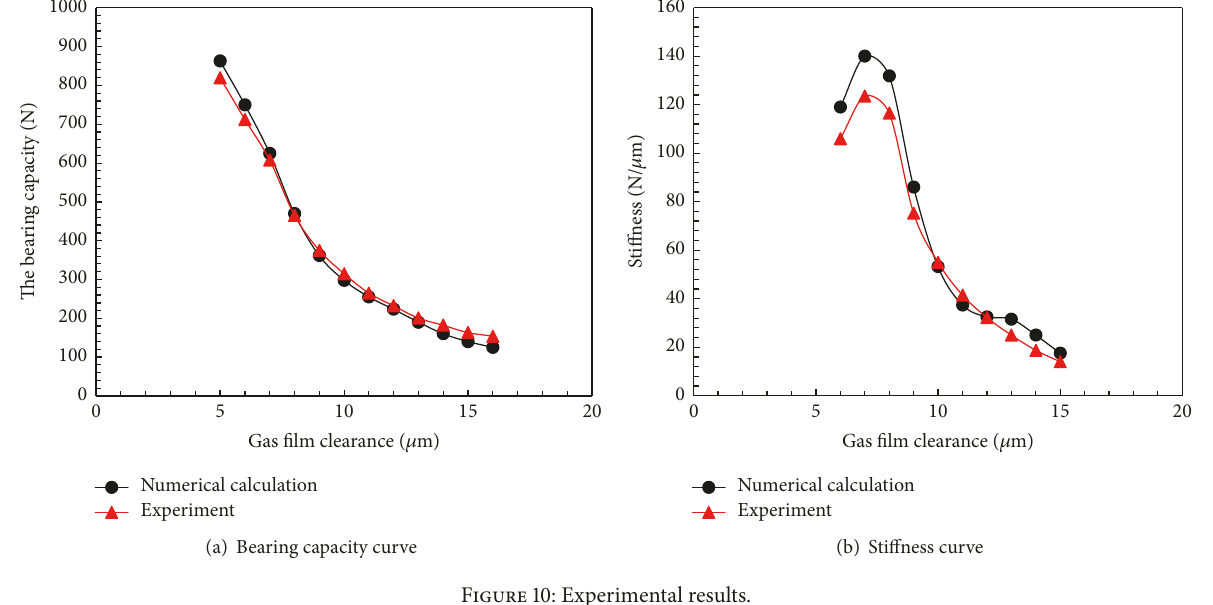
Figure 10: Experimental